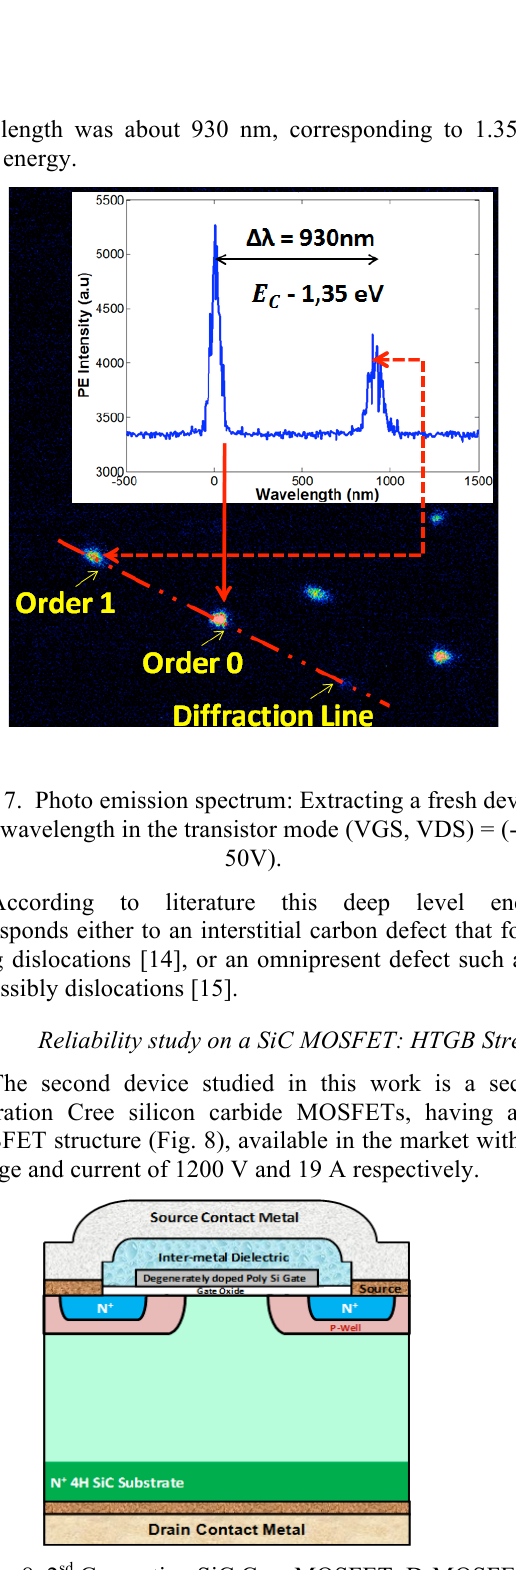
Fig. 8. 2 sd Generation SiC Cree MOSFET: D-MOSFET Structure [16]